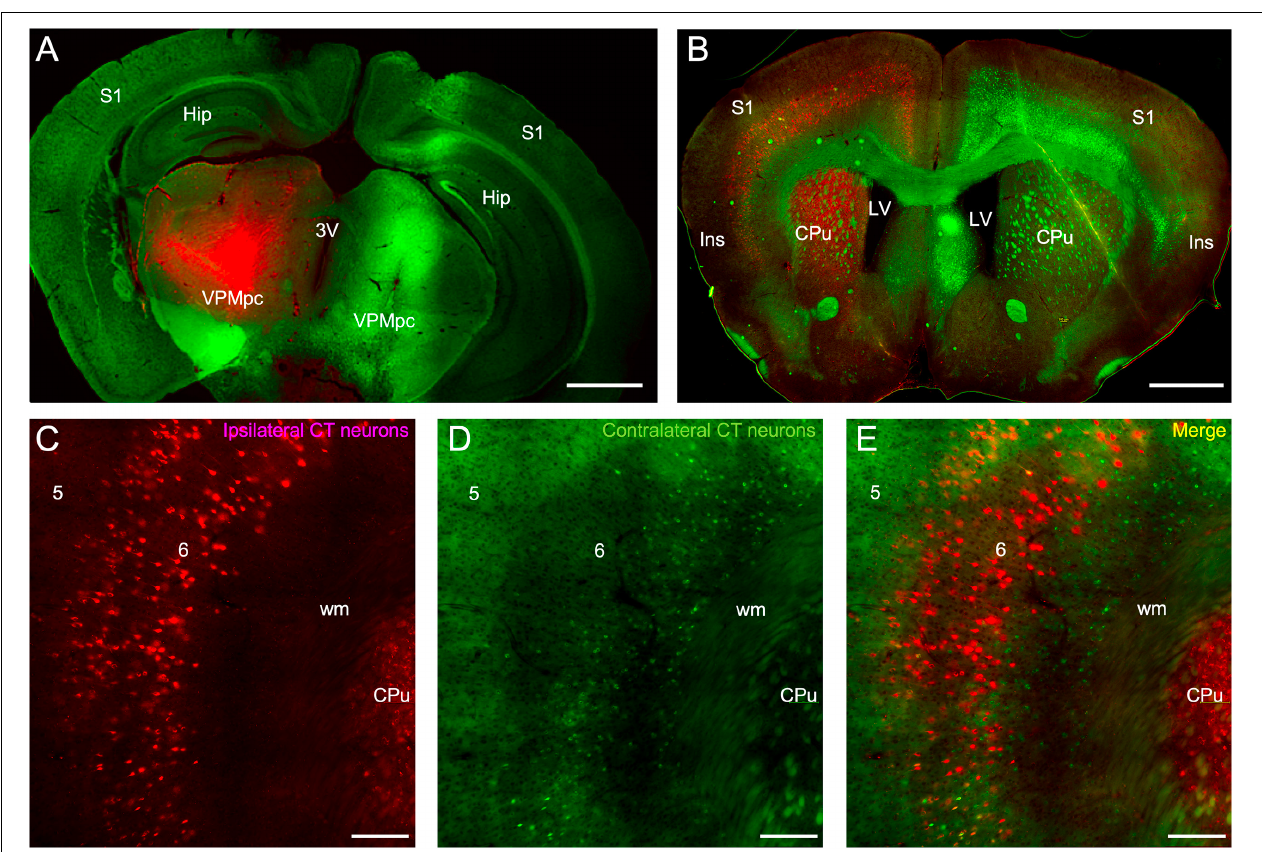
FIGURE 2 | Retrograde labeling of insular corticothalamic neurons. (A) Injections of either fluorogold (green) or fluororuby (red) were stereotactically targeted to the left and right VPMpc. Some injection site damage was observed, possibly due to injection speed. (B) Retrograde labeling was observed in the respective ipsilateral insular cortical area but was also evident in the contralateral insular cortex. Labeling was also found in other ipsilateral cortical areas, such as S1, indicative of some injection spread into adjacent thalamic nuclei, such as the ventral posterior nuclei (VP) and posteromedial nucleus (POm). (C–E) Both the retrogradely labeled ipsilateral CT neurons (red labeling in this instance) and the contralateral CT neurons (green neurons in this instance) originated from layer 6. Contralateral projecting neurons appeared smaller than ipsilateral projecting neurons, perhaps reflecting differences of labeling efficiency or morphological class. However, the contralateral CT neurons were interdigitated with the ipsilateral CT neurons and double-labeled neurons projecting to both thalami were rare, indicating that separate neuronal populations project to either the ipsilateral or contralateral thalami. Abbreviations are the same as in Figure 1 . Scale bars: (A,B) : 1 mm; (C–E) : 200 µ